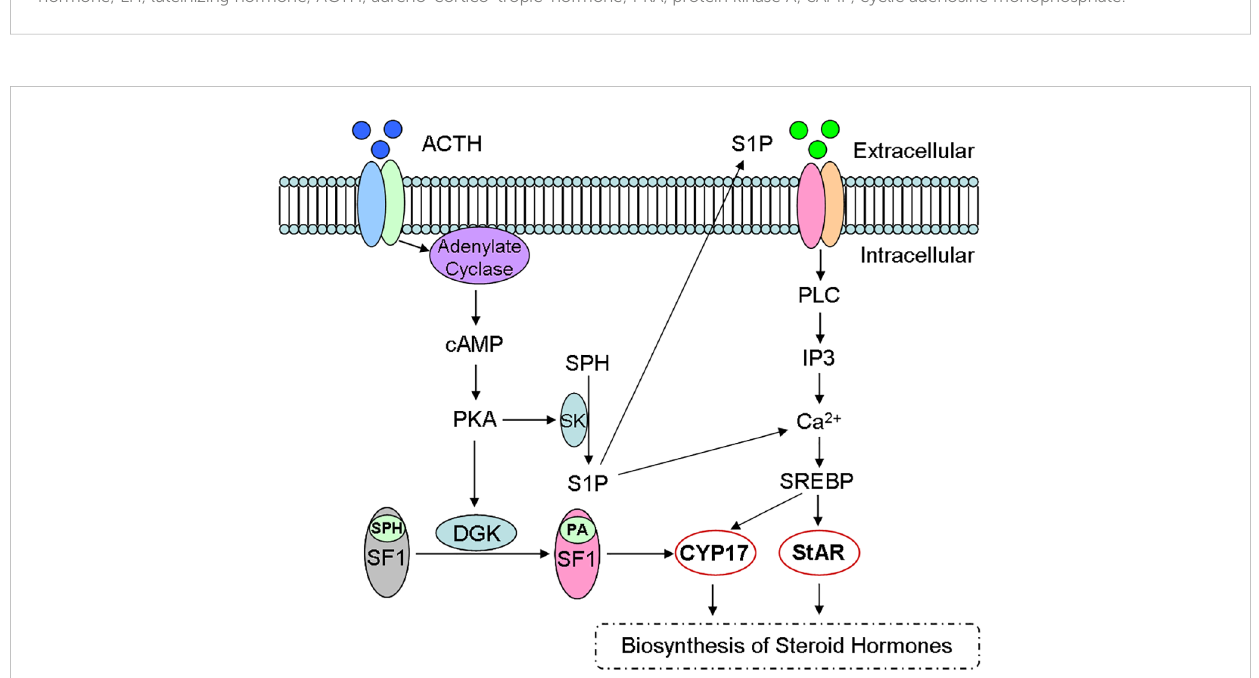
FIGURE 4 Sphingolipid metabolites and steroid biosynthesis. Steroid hormones are synthesized mainly via cAMP/PKA signaling pathway and sphingolipids act as the second regulator during the steroidogenesis. For example, ACTH activates cAMP/PKA signaling, reduces sphingomyelin number and increases S1P production, which participates in the biosynthesis of Steroid hormones through CYP and StAR activity. ACTH, adreno corticotropic hormone; cAMP, cyclic adenosine monophosphate; PKA, protein kinase A; DGK, diacylglycerol kinase; SPH, sphingosine; SF-1, steroid forming factor-1; PA, phosphatidic acid; SK, sphingosine kinase; S1P, sphingomyelin-1-phosphate; CYP, cytochrome P450; StAR, steroidogenic acute regulatory protein.